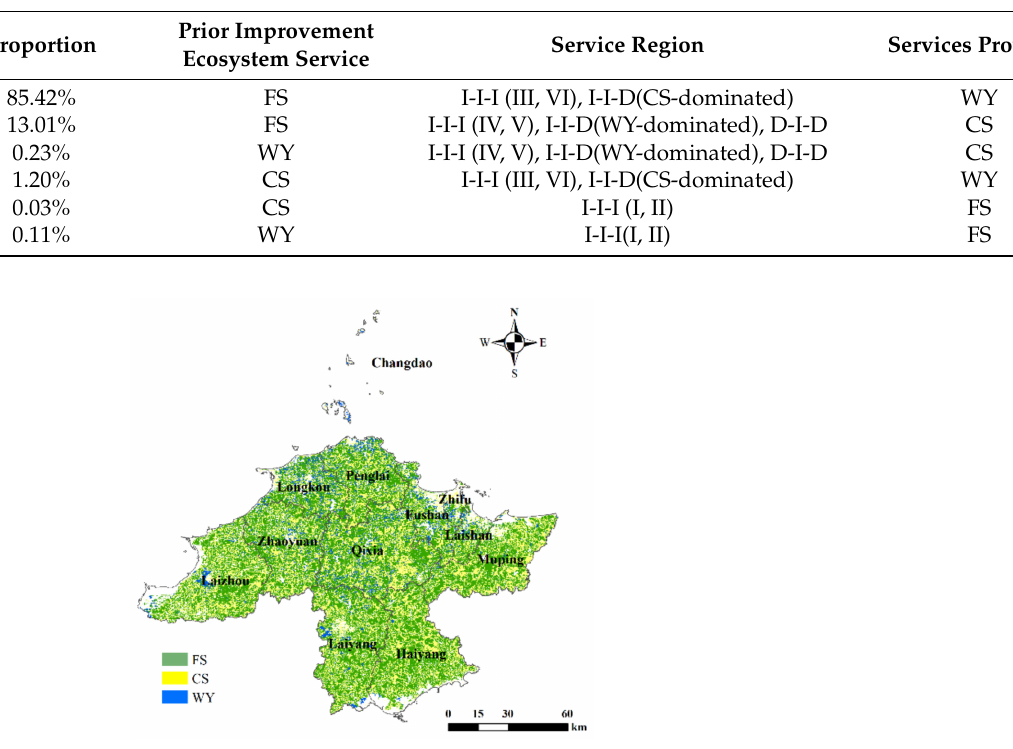
Figure 14. Spatial prior improvement of ecosystem services in